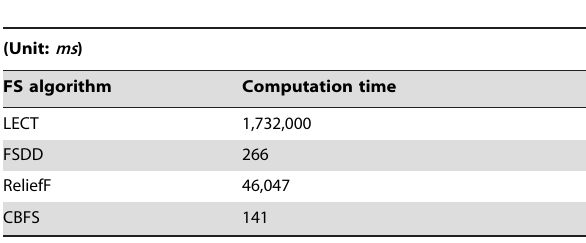
Table 3. Computation time of feature selection for the Madelon dataset.